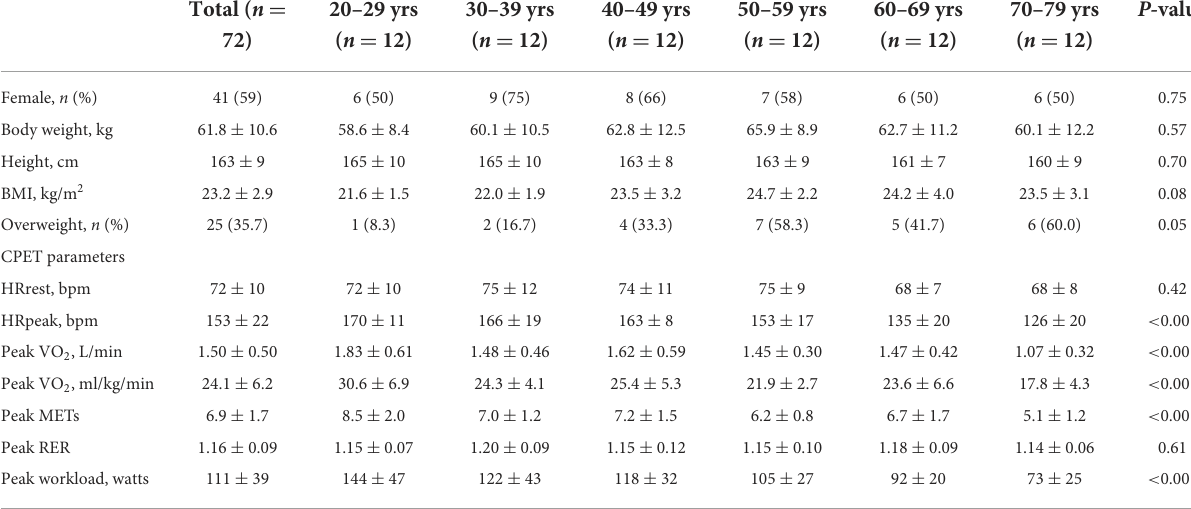
TABLE 1 Demographics of the